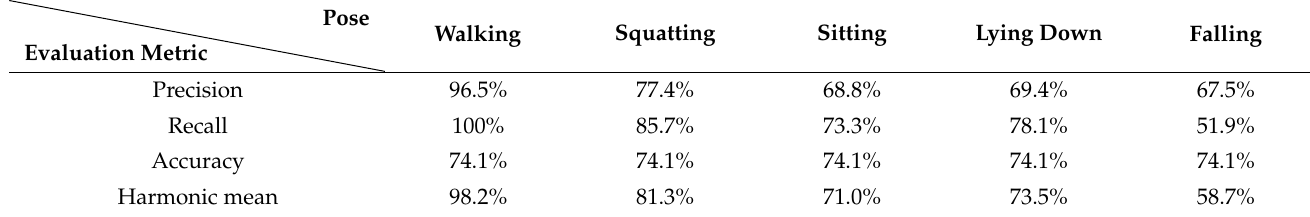
Table 2. Evaluation data for the pose detection of a falling elderly man.